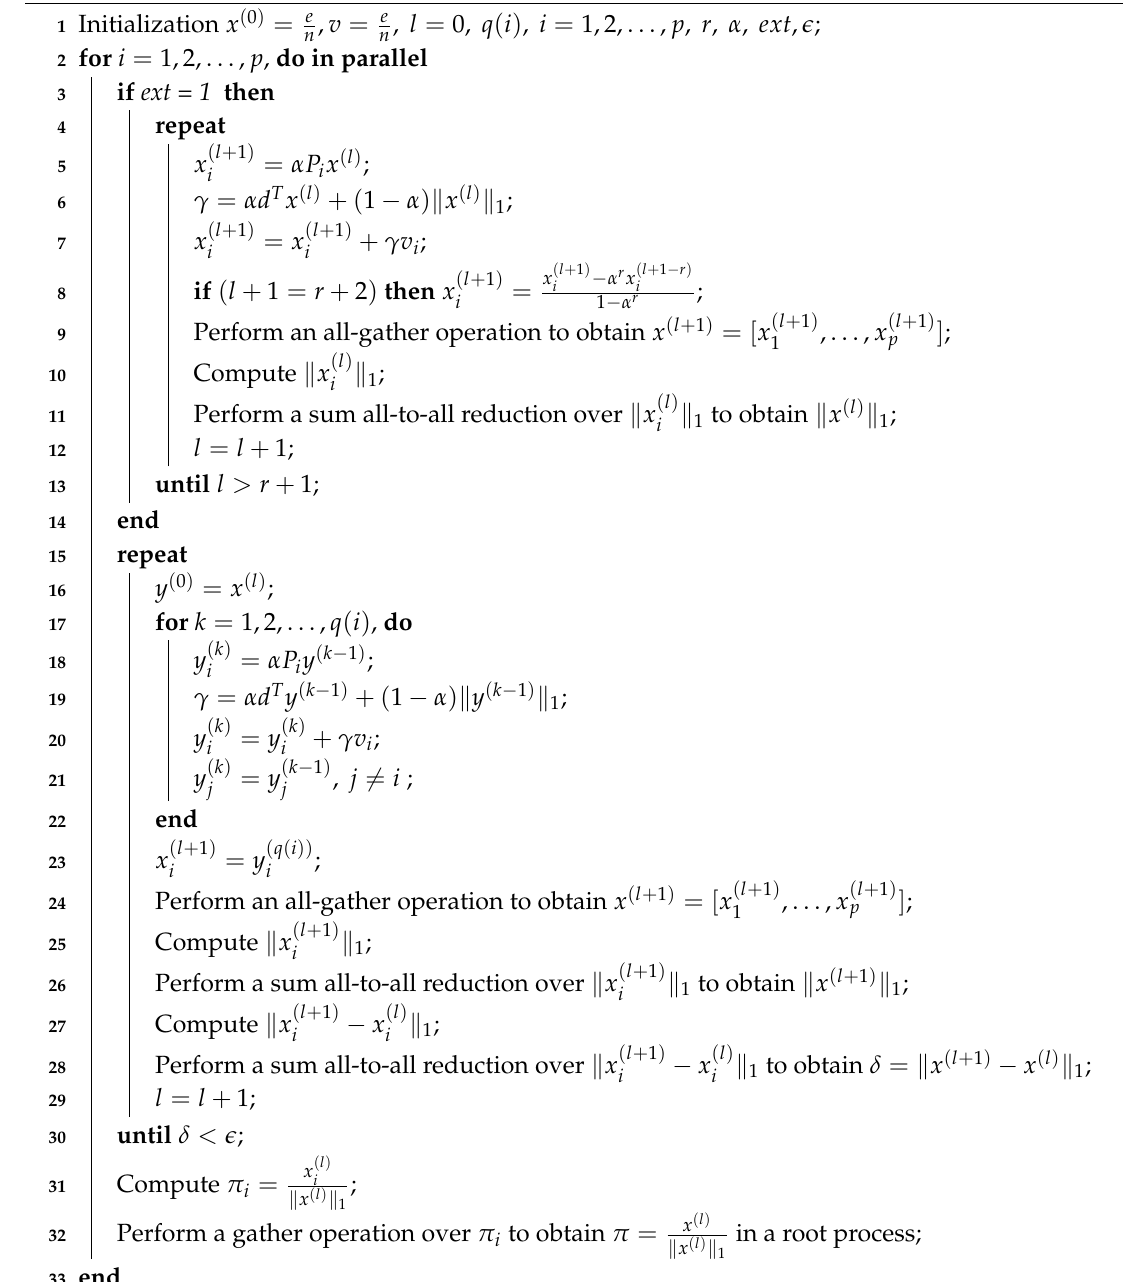
Algorithm 7: Parallel algorithms for solving